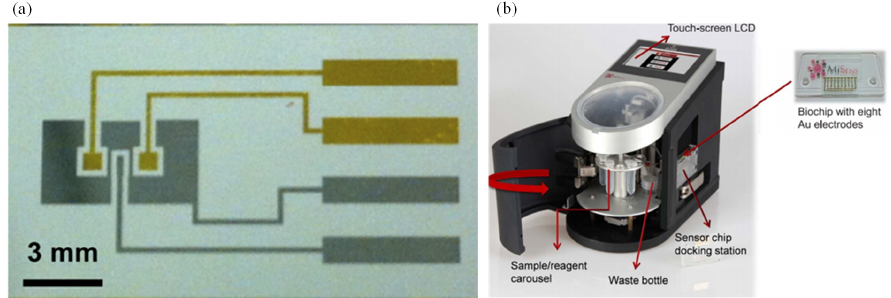
Figure 6. ( a ) Electrochemical DNA-based sensor for E. coli determination [118] and ( b ) custom-made automatic biosensor for pathogenic detection